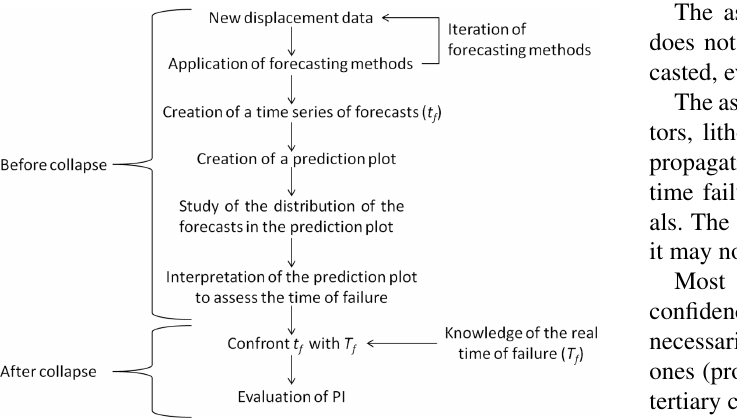
Figure 4. Flow chart that synthesizes the proposed